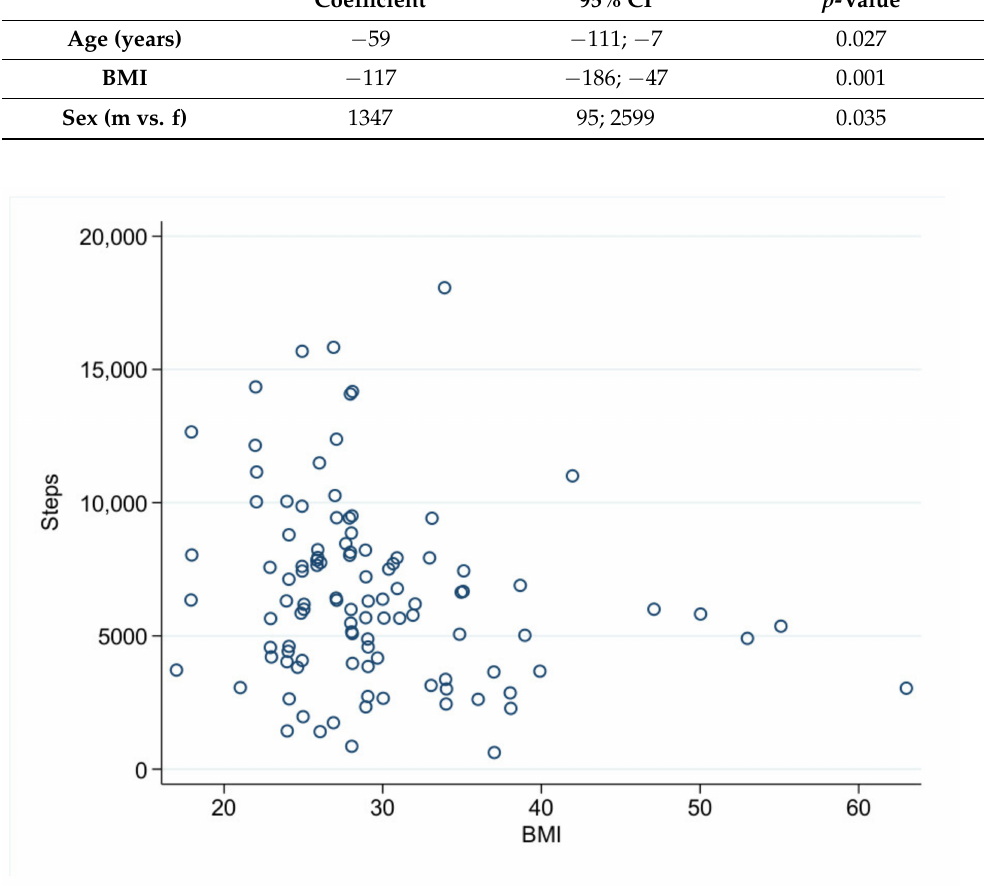
Figure 3. Steps vs. BMI